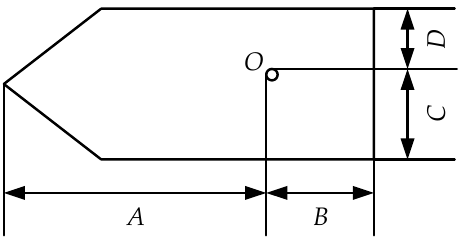
Figure 3. The reference point for reporting position and overall dimensions of a ship.